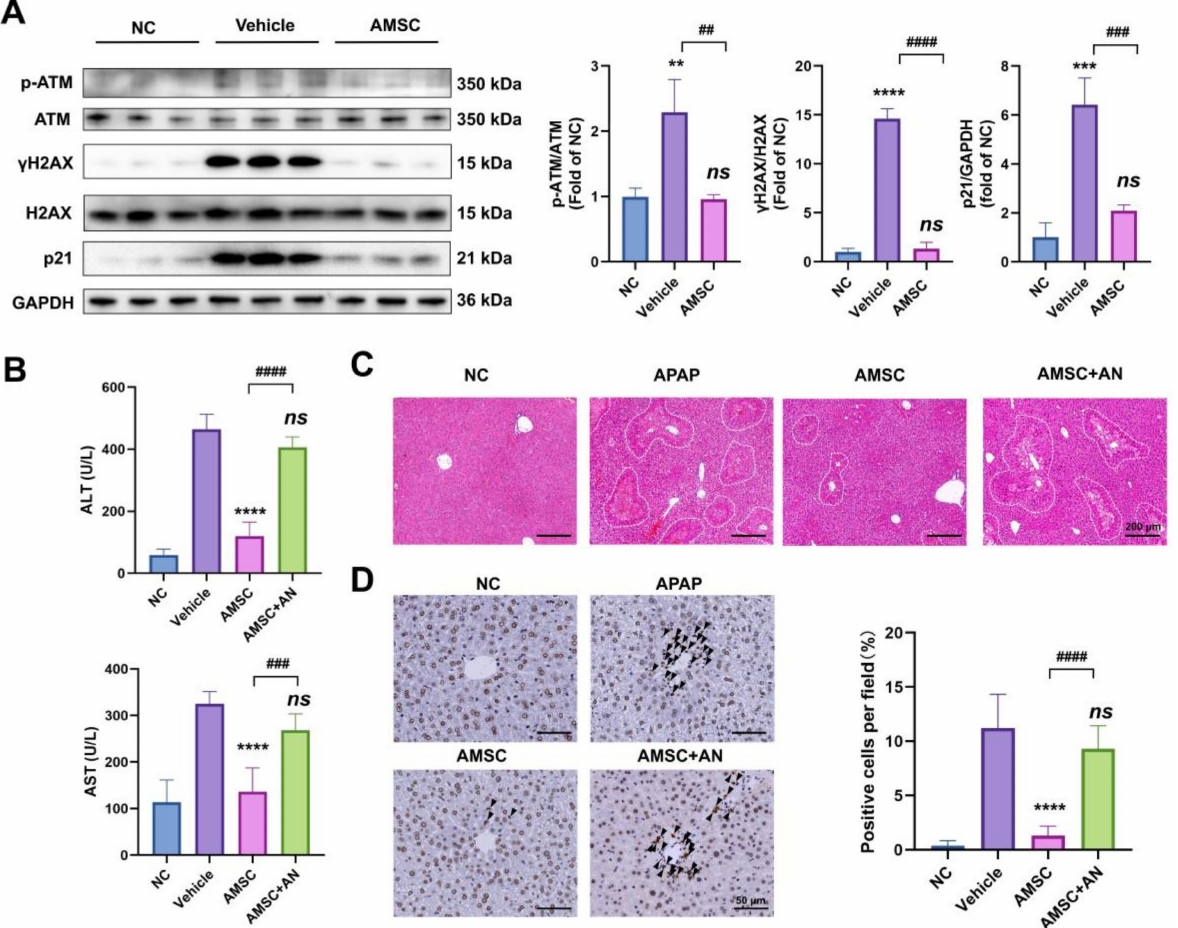
Figure 8. AMSCs inhibit the JNK-ATM mitochondrial retrograde pathway in AILI. ( A ) Immunoblots and quantitative histograms showing the results of Western blotting analysis for p-ATM, ATM, γ H2AX, H2AX and p21 protein expression. ( B ) The AST and ALT levels after treating with AMSCs and AN. ( C ) Representative H&E staining of each group. ( D ) Liver tissues were stained for γ H2AX and quantified. Representative IHC images are shown. Data are presented as the mean ± SD; n = 3–5; ** p < 0.01, *** p < 0.001, **** p < 0.0001 and ns: no significance vs. NC group and